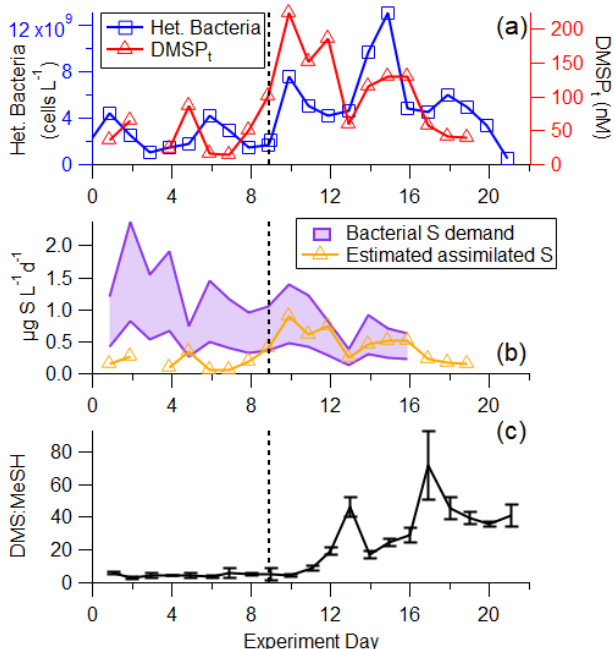
Figure 6. (a) Time series of heterotrophic bacteria and DMSP t . (b) Time series of calculated bacterial sulfur demand (cellular C:S in bacteria of 86–248) and estimated assimilated sulfur assuming 25% of DMSP t is assimilated by bacteria (Fagerbakke et al., 1996; Cuhel et al., 1982; Kiene and Linn, 2000a). (c) DMS:MeSH is low in the pre-bloom at the beginning of the experiment, before increas- ing significantly driven by different sources of available sulfur. The vertical line represents the addition of productive seawater and ad- ditional nutrients to the wave